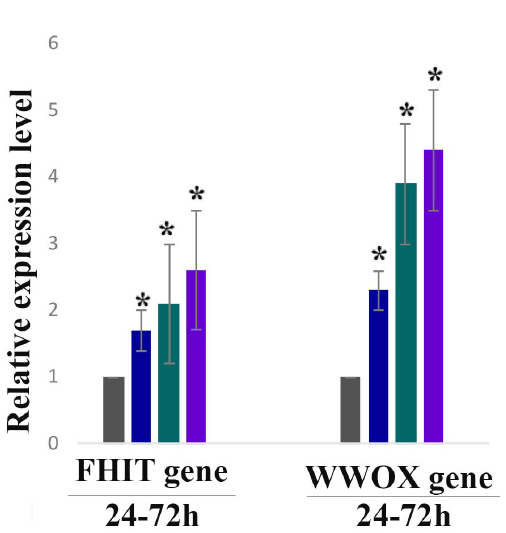
FIGURE 4 – Relative expression levels of FHIT and WWOX genes. The cells were treated with TSA (5 Mμ) for different time periods (24, 48, and 72 h) and Quantitative real-time RT-PCR was done to determine the FHIT and WWOX genes expression. The first column of each group belongs control group and other columns belong various period times (24, 48, and 72 h) respectively . Data are presented as the mean ± standard error of the mean from three different experiments. Asterisks (*) indicate significant differences between treated cells and the control group. The first column of each group belongs to the control